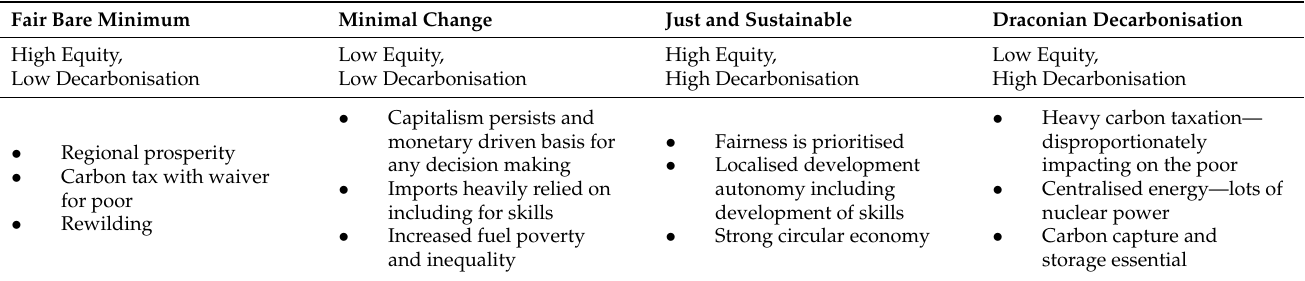
Figure 1. North of Tyne Energy Futures 2 × 2 Matrix (Copeland, MacKerron & Foxon, 2022, Figure 2 in [45]). Table 2. North of Tyne Narrative Energy Futures—Summary Features